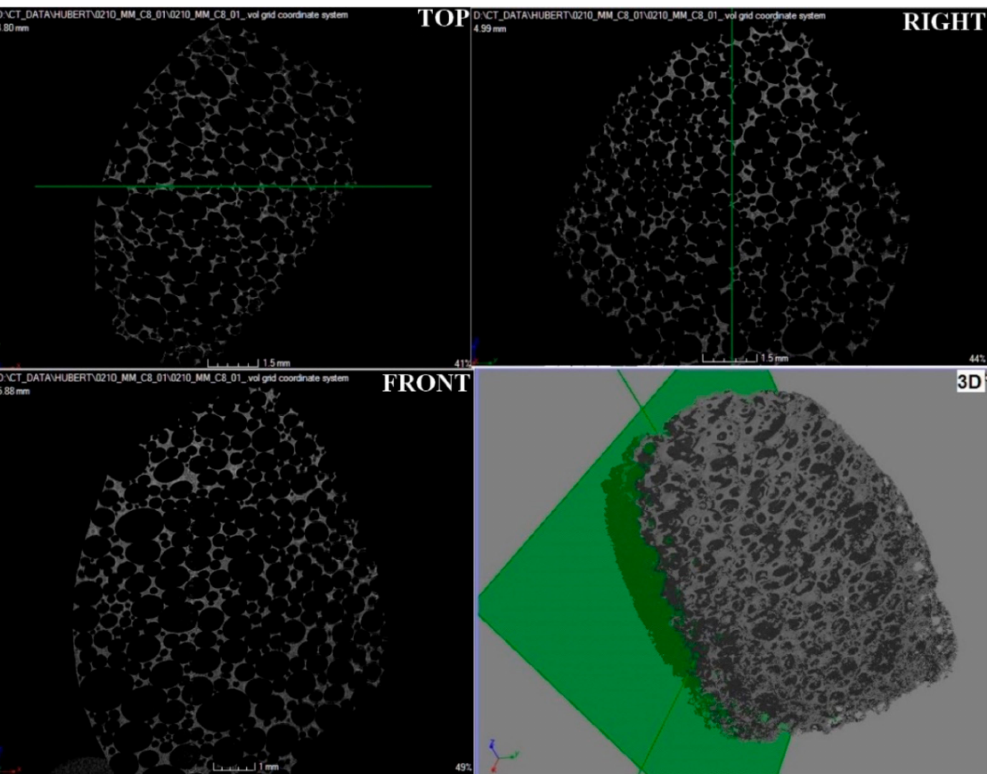
Figure 15. Microtomographic image of carbon sample M1, TOP—top view, FRONT—front view, RIGHT—right view, and 3D—three-dimensional view.